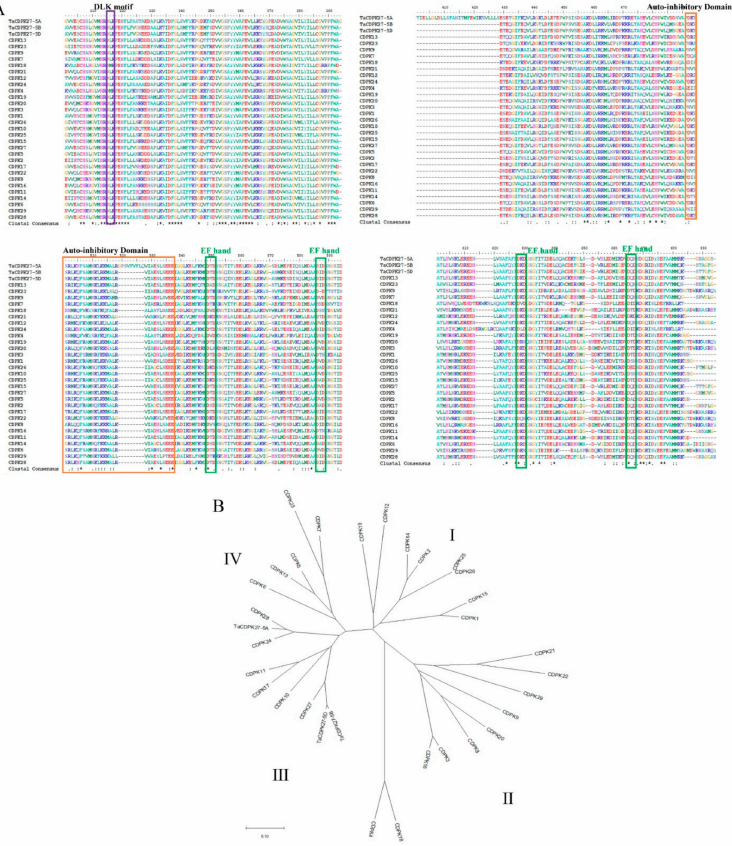
Figure 3. Sequence analysis of TaCDPK27. ( A ) Multi-sequence alignment of TaCDPK27 with other CDPK proteins from rice. Amino acid sequences from 29 function-known CDPKs share similar structures, containing DLK motif, a serine/threonine kinase-like domain (S-TKc), and four EF-hand motifs. Ta, Triticum aestivum L. ( B ) Phylogenetic analysis of TaCDPK27. I, II, III and IV indicate the subgroups of CDPK family. TaCDPK27 and function-known CDPKs in rice are used to construct their phylogenetic tree using MEGA-X software.